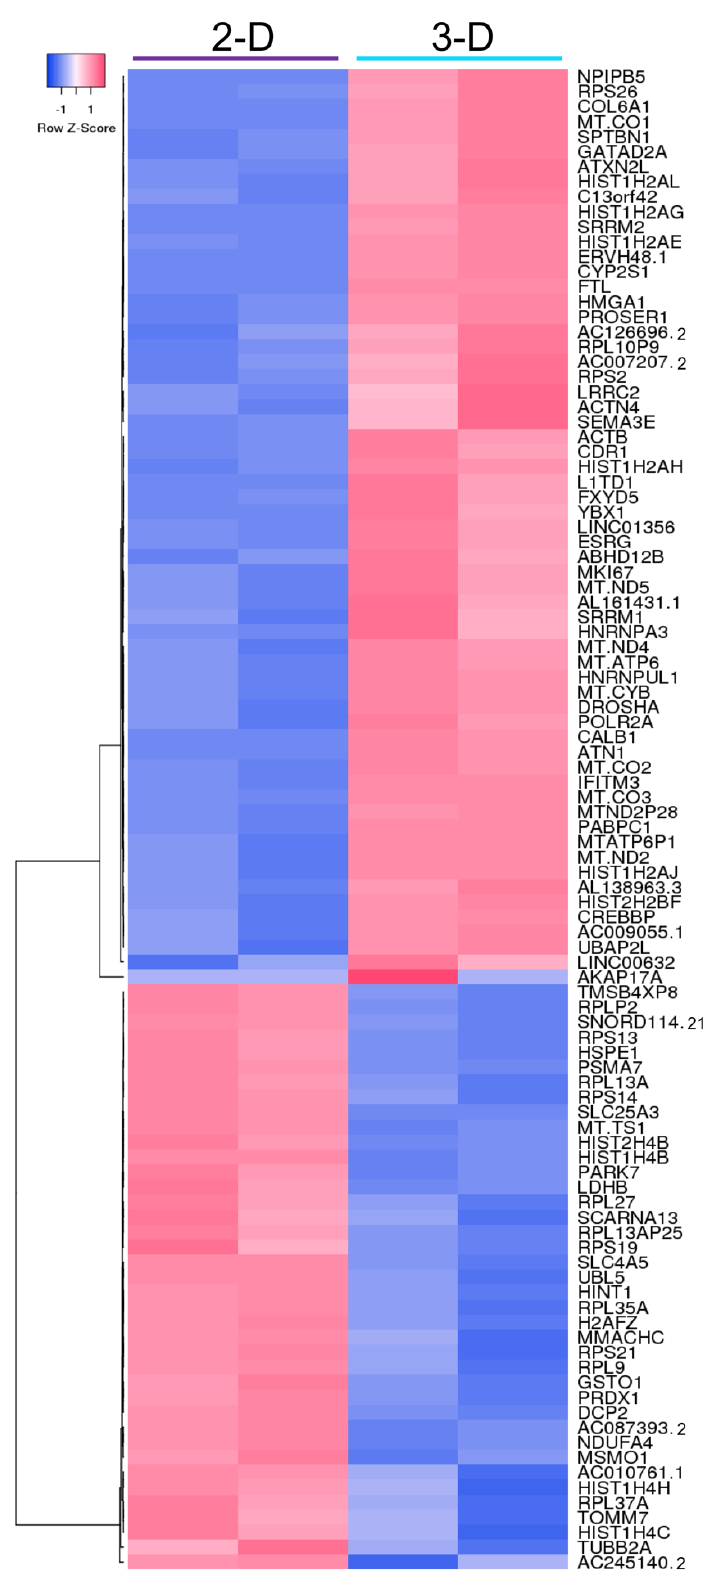
Figure 4. Heatmap showing raw z-scores of RNA-seq log2 transformed values of the top 100 differentially expressed genes in 2-D and 3-D cultured Elf1 cells. Up- and downregulated genes are red and blue, respectively.